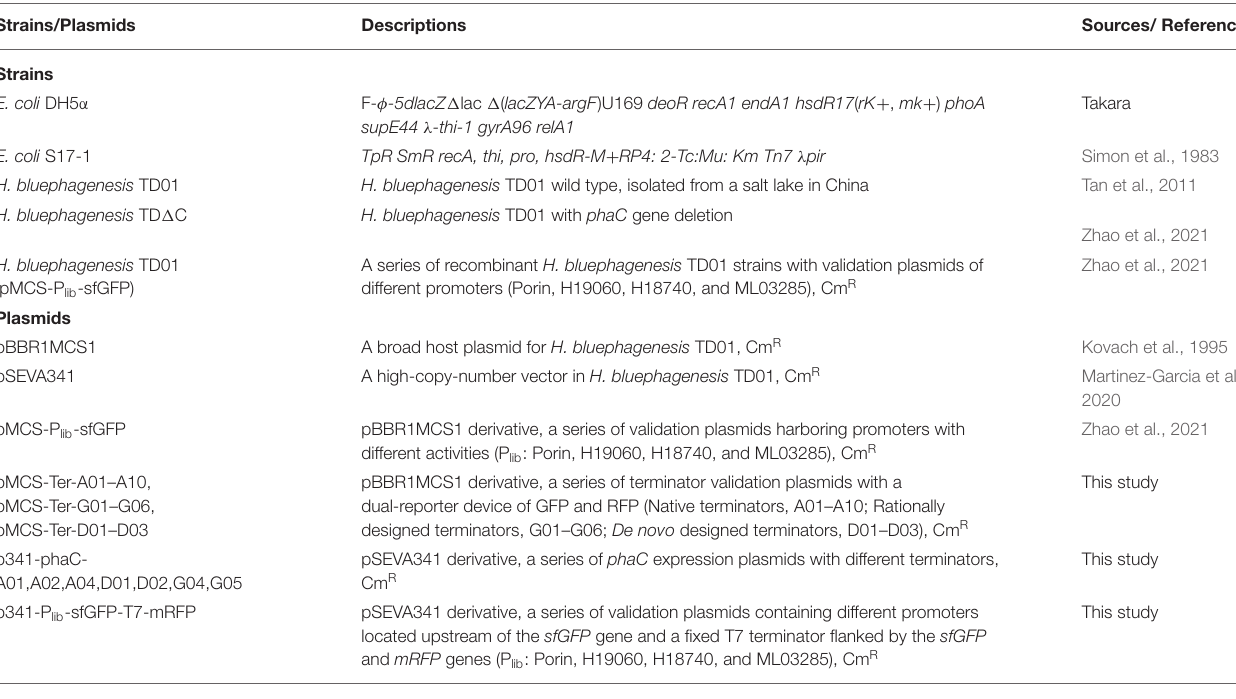
TABLE 1 | Bacterial strains and plasmids used in this study.